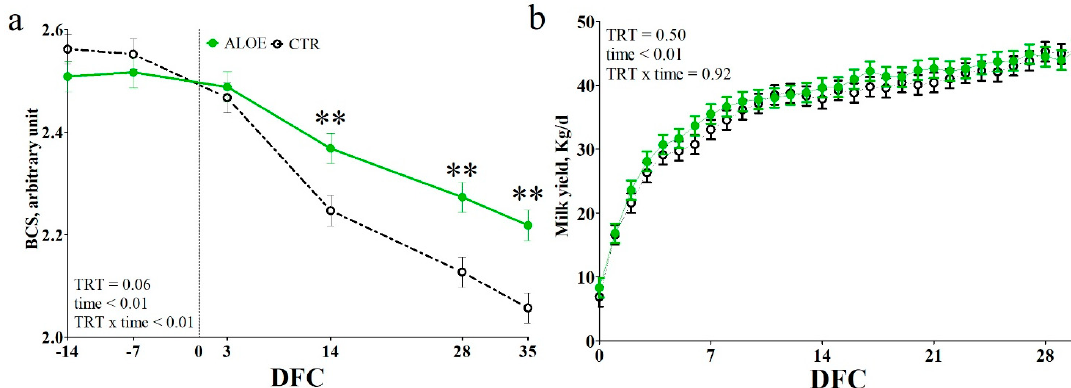
Figure 2. Values of BCS ( a ) and milk yield ( b ) in dairy cows receiving placebo water (CTR; black dotted line) or cows receiving a drench of 200 g/d of Aloe arborescens Mill . whole plant homogenate between − 14 and 14 days from calving (AAM; green solid line). ** is p < 0.01; DFC is days from calving. Table 2. Milk composition and somatic cell count in control dairy cows or cows receiving 200 g / d of Aloe arborescens Mill. homogenate extract as a drench between − 14 and 14 days from calving. Item,